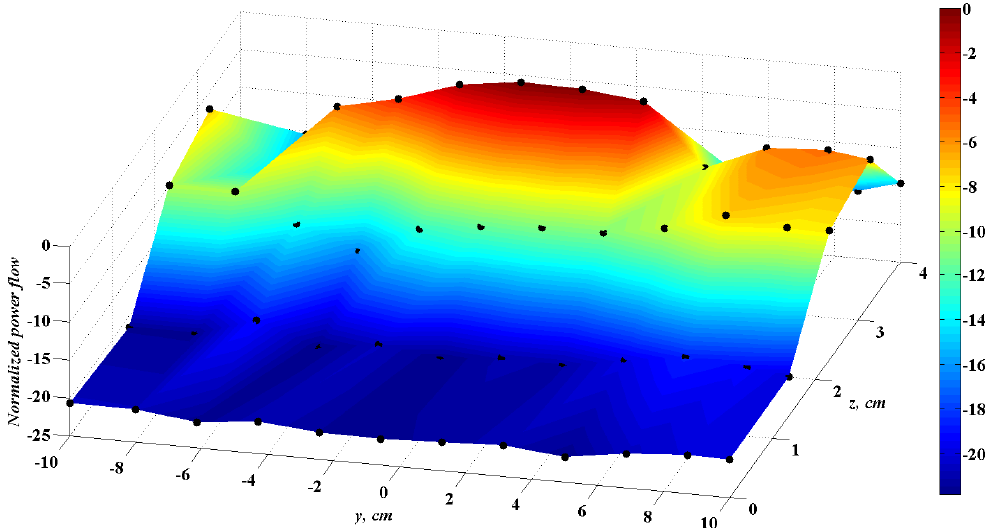
Figure 13. Computed normalized power flow distribution for rectangular skin-equivalent phantom at d = 5